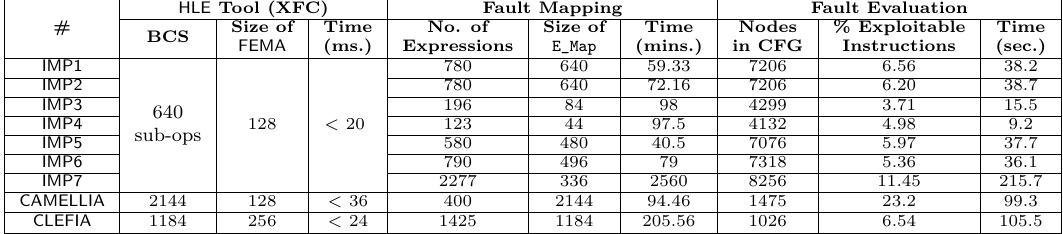
Table 6: Statistics of outputs from the three different steps of FEDS for 7 AES imple- mentations given in Table 2, CAMELLIA and CLEFIA. The entire framework was